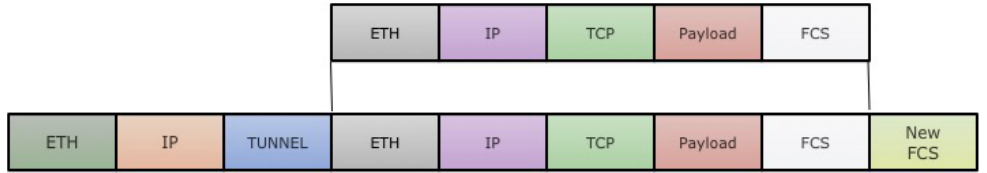
Figure 1. Network packet